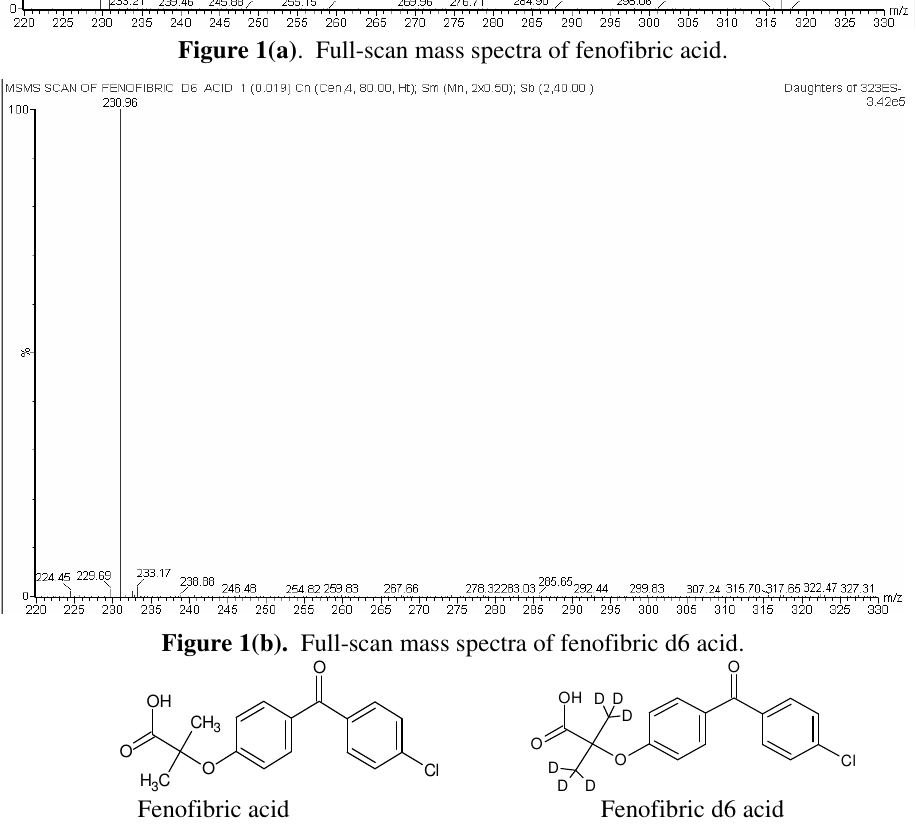
Figure 1(a) . Full-scan mass spectra of fenofibric acid.